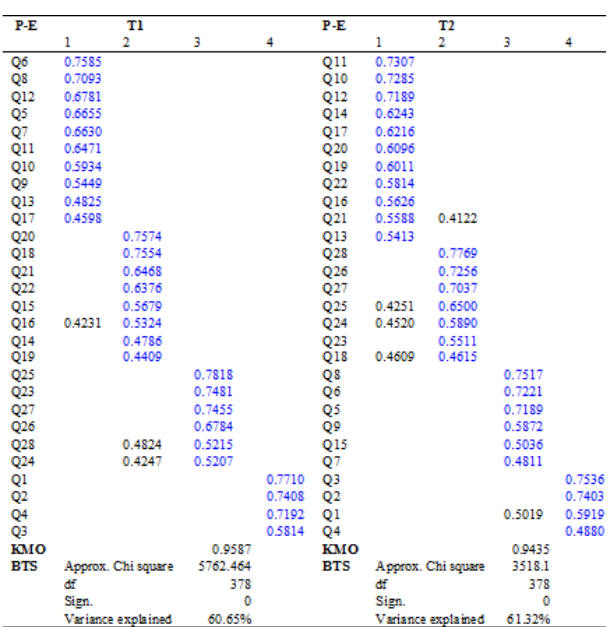
Table 4: Factor loading matrices for gaps (P-E) time T1 and